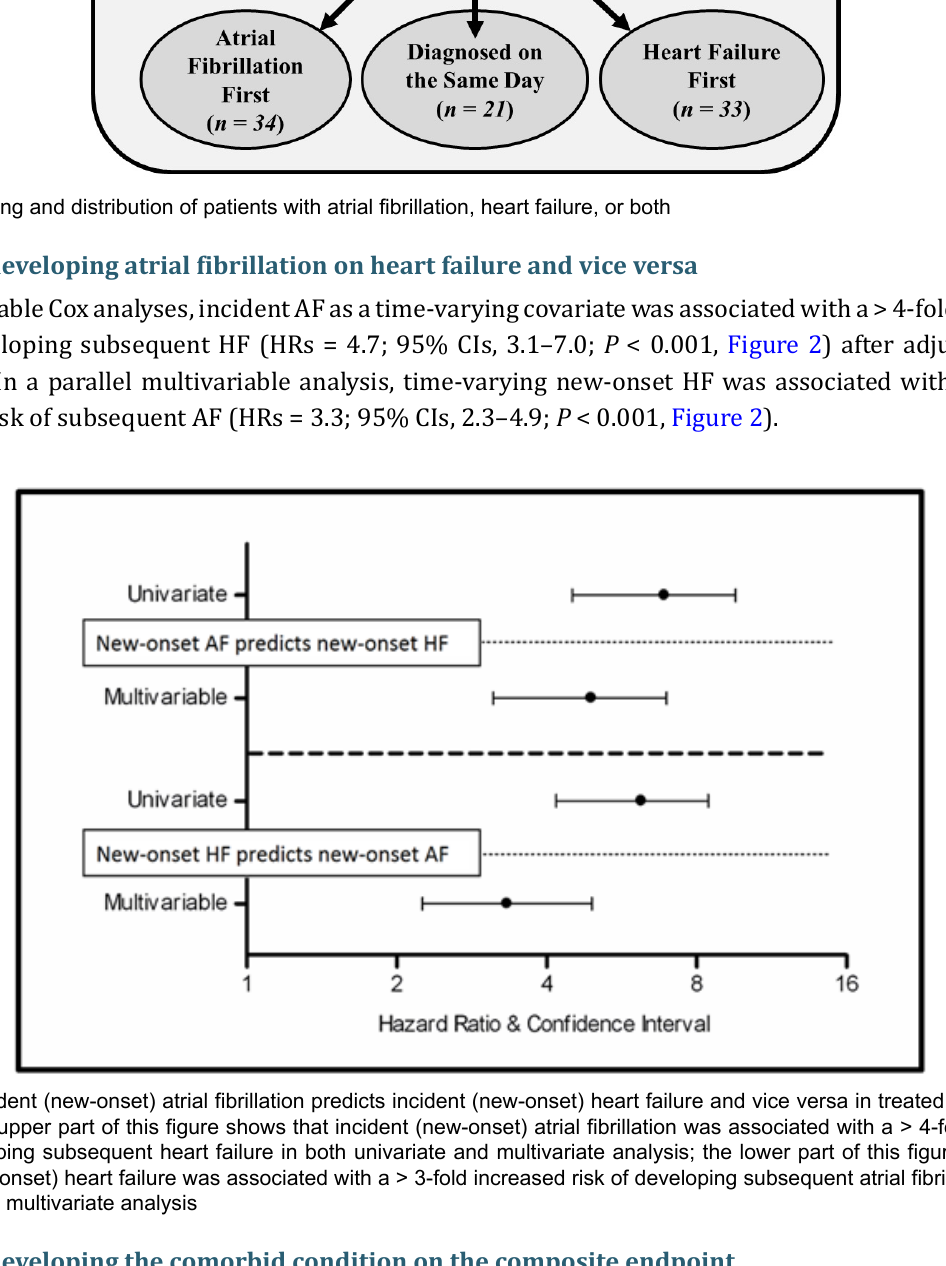
Figure 2. Incident (new-onset) atrial fibrillation predicts incident (new-onset) heart failure and vice versa in treated hypertensive patients. The upper part of this figure shows that incident (new-onset) atrial fibrillation was associated with a > 4-fold increased risk of developing subsequent heart failure in both univariate and multivariate analysis; the lower part of this figure shows that incident (new-onset) heart failure was associated with a > 3-fold increased risk of developing subsequent atrial fibrillation in both univariate and multivariate